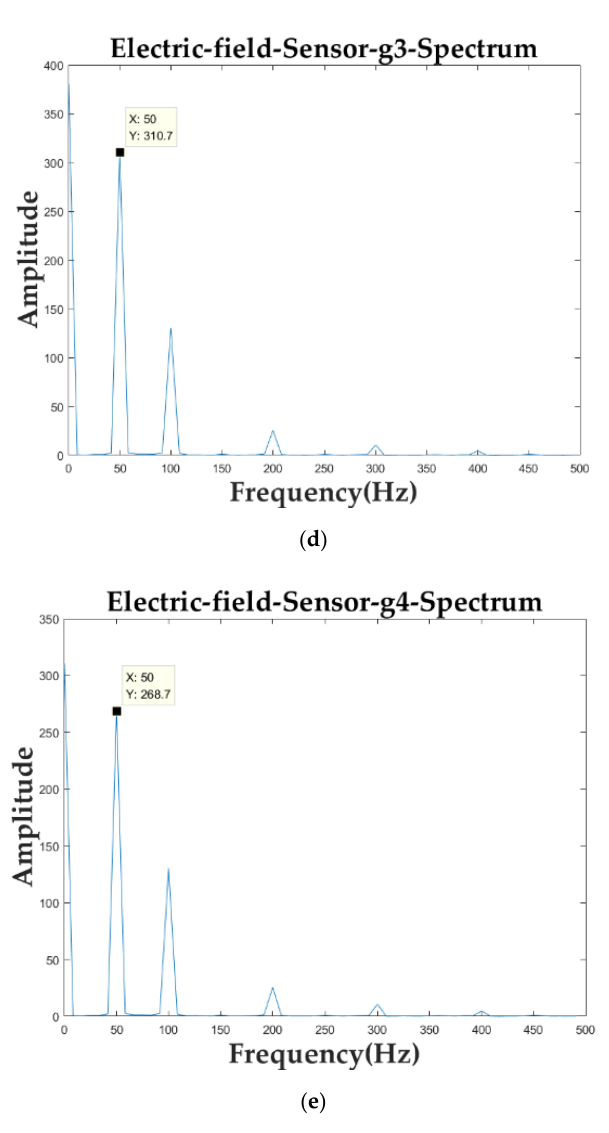
Figure 24. Sensor array data spectrogram.(a) Spectrum of sensor g0;(b) Spectrum of sensor g1;(c) Spectrum of sensor g2;(d) Spectrum of sensor g3;(e) Spectrum of sensor g4